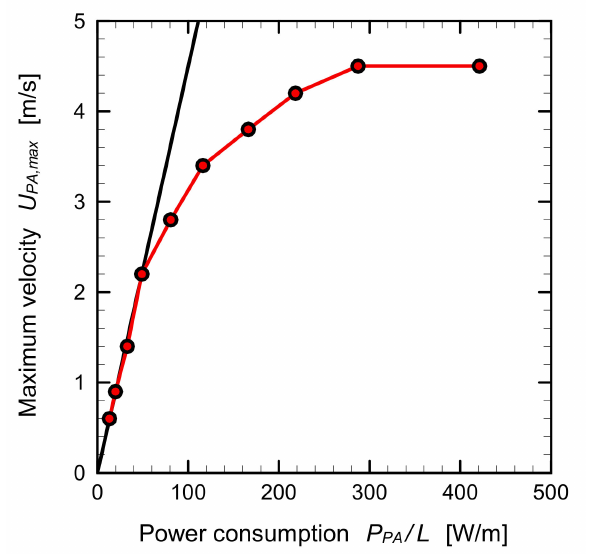
Figure 9. Relationship between power consumption and maximum